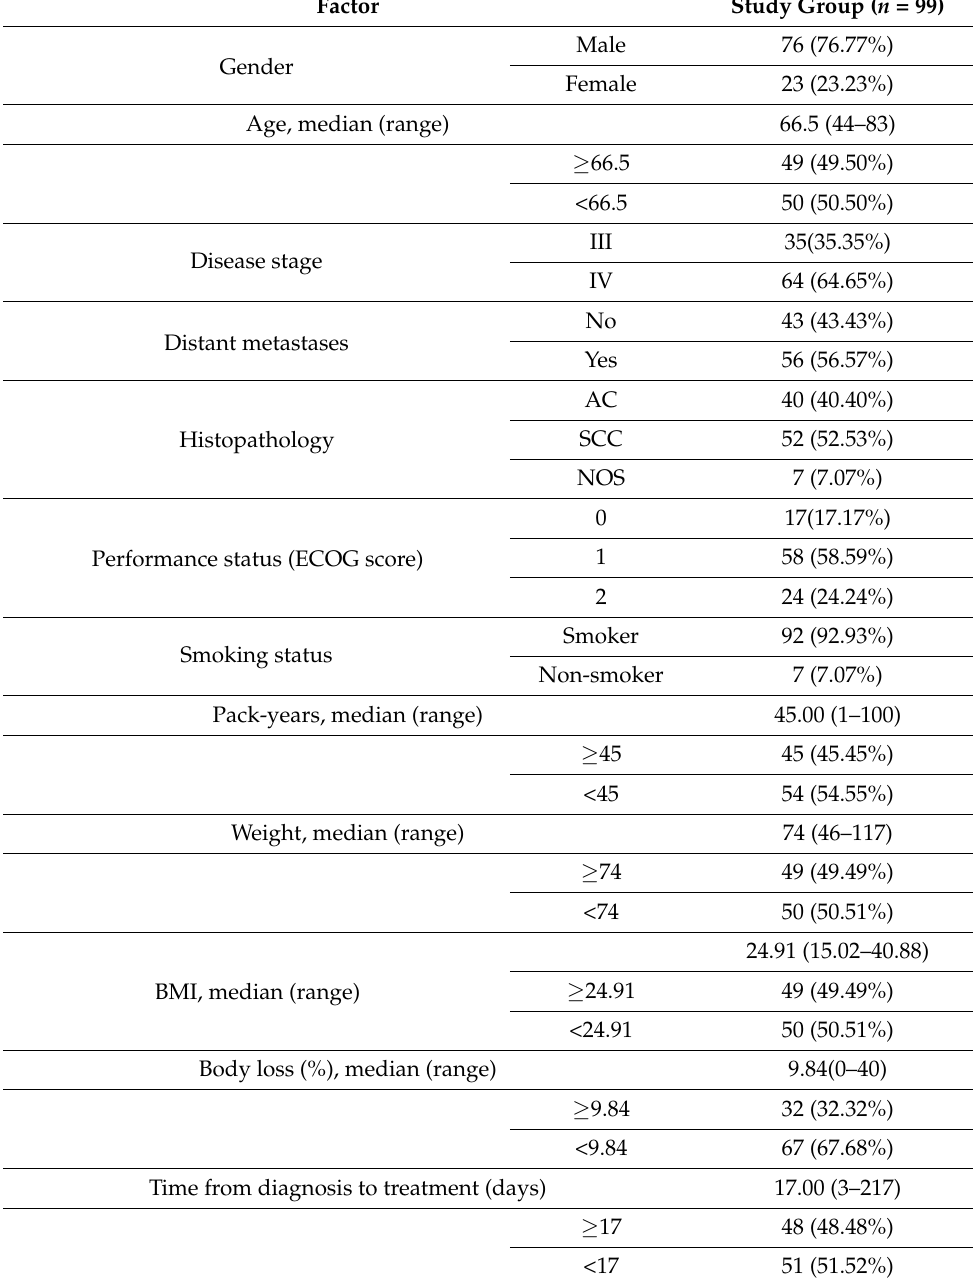
Table 1. Characteristics of the study